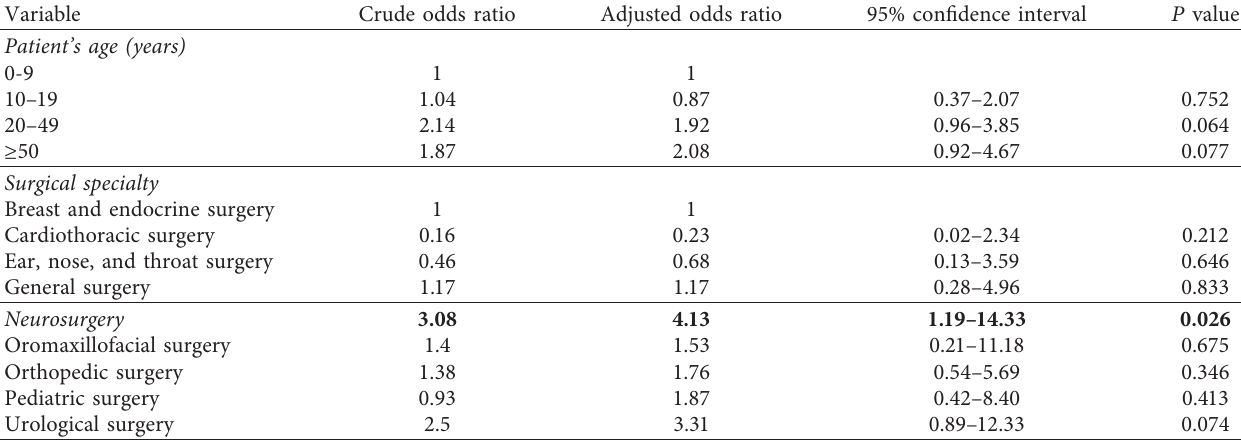
Table 4: Multivariate logistic regression analysis of factors associated with cancellation of elective procedures in surgical wards at Mulago Hospital,